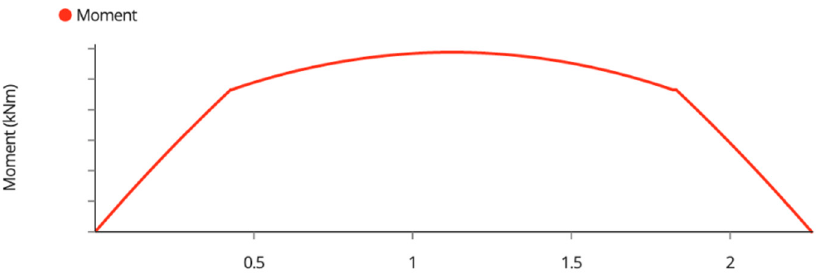
Figure A7. The 2 × 4 Weight Bending Moment Diagram.